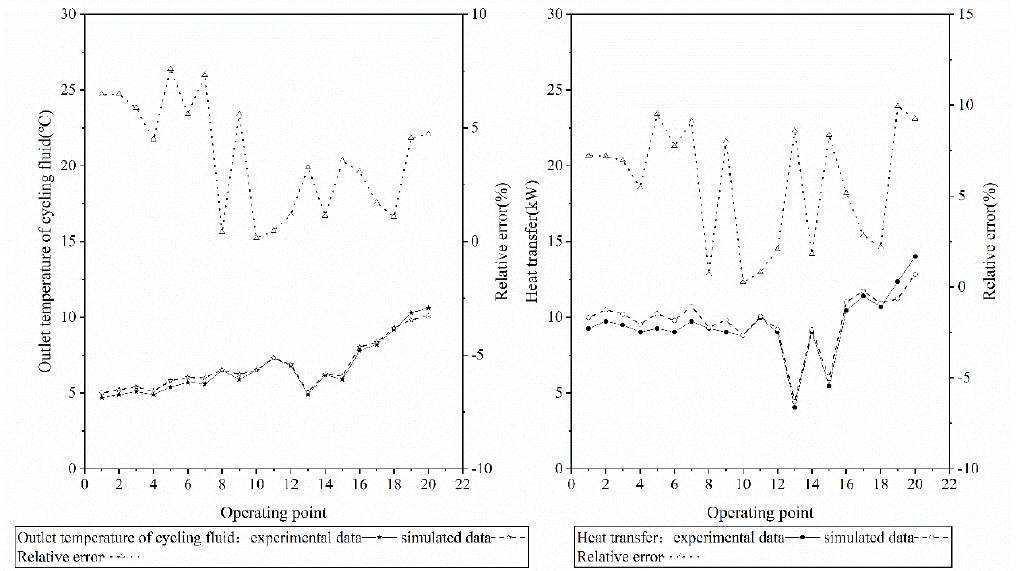
Figure 4. Comparison of experimental and simulated values of circulating fluid’s outlet temperature and the heat-source tower’s heat transfer. Table 4. The mean relative error (MRE) and RE max between experiments and simulation results. Comparison of Experimental and Simulated